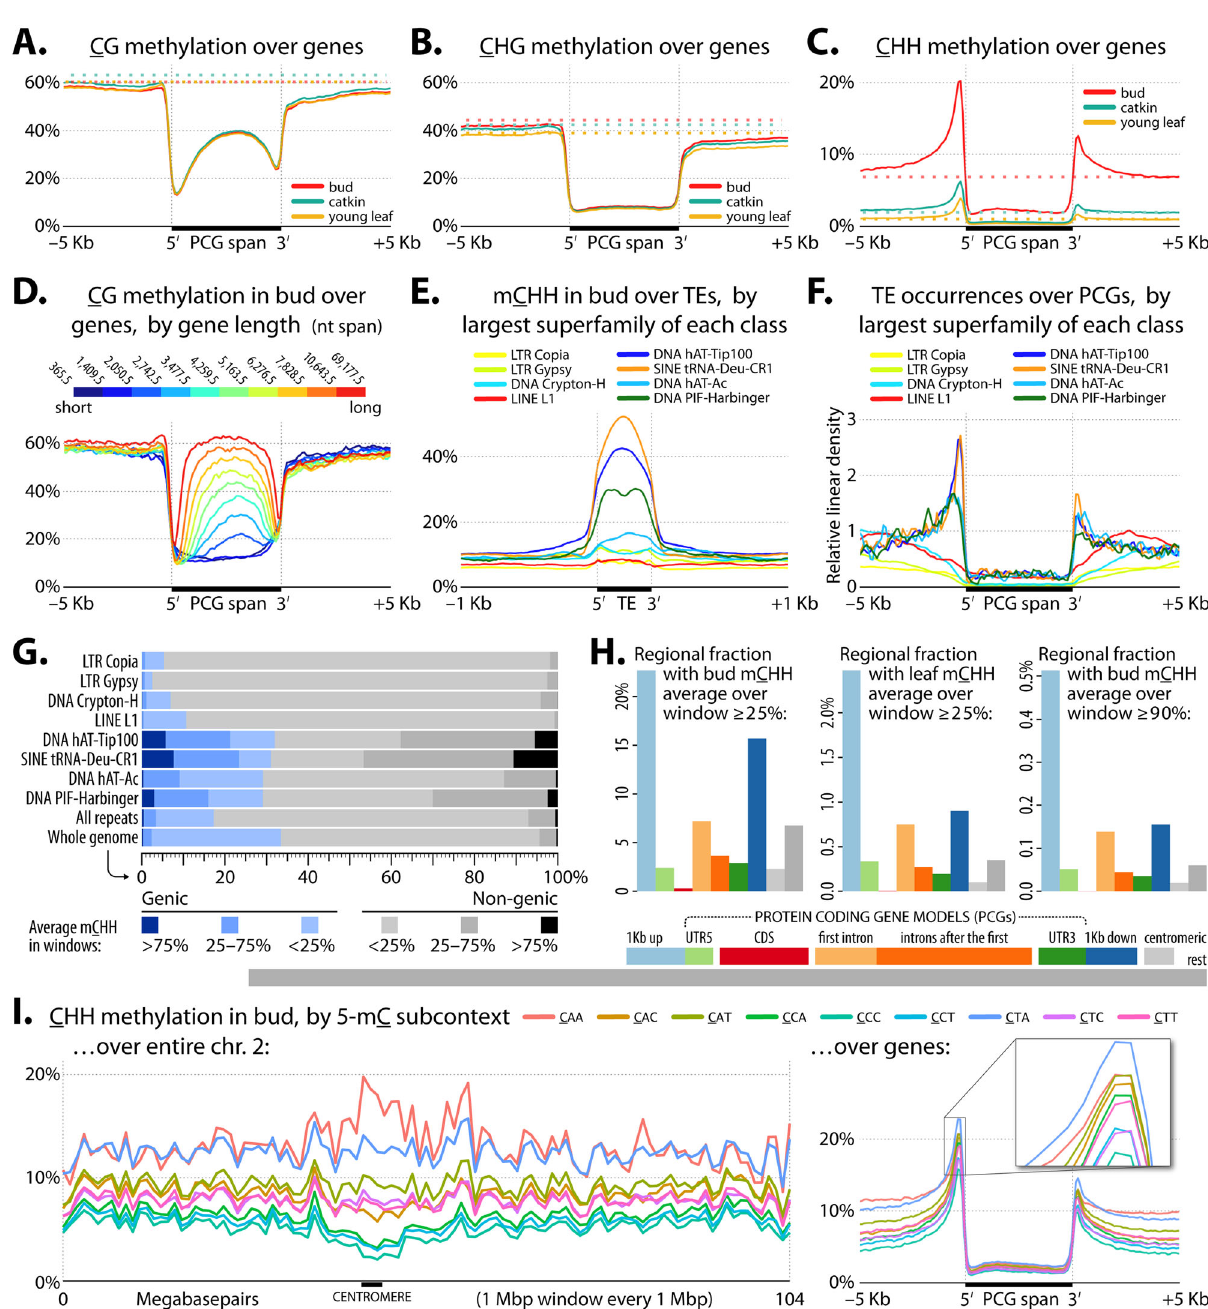
Fig. 5 DNA methylation in protein-coding genes and repeats. A – C Average methylation levels (100 bp windows, introns included) with respect to PCGs (normalized to 5 kbp long) for the three sampled tissues (bud, catkin, and young leaf) by methylation context: A CG, B CHG, and C CHH. Dotted lines show genome-wide backgrounds, and TSS/TES = transcription start/end site. Supplementary Fig. 18 shows plots with introns excluded. D mCG for genes in deciles by gene length. E Average bud mCHH (20 bp windows) across representative repeat SFs (normalized to 400 bp long) in selected RepeatClassi fi er minor classes. F Relative density of representative repeat SFs around genes (100 bp windows). G Distribution of mCHH for representative repeat SFs (100 bp sliding disjoint windows). Genic = gene spans enlarged by 1 kbp on each end. H Partitioning of whole-genome base pairs into nine types of regions vs. mCHH coverage. Lower horizontal bars re fl ect relative size. Vertical bars show the percent of each genomic context covered by 100 bp windows with mCHH >25% or >90% in bud or young leaf. I mCHH by 3 nt subcontext (queried cytosine is underlined, and is the fi rst nt of the three): left side 1 Mbp windows across all of chr. 2, right side across genes (normalized to 5 kbp length) in bud